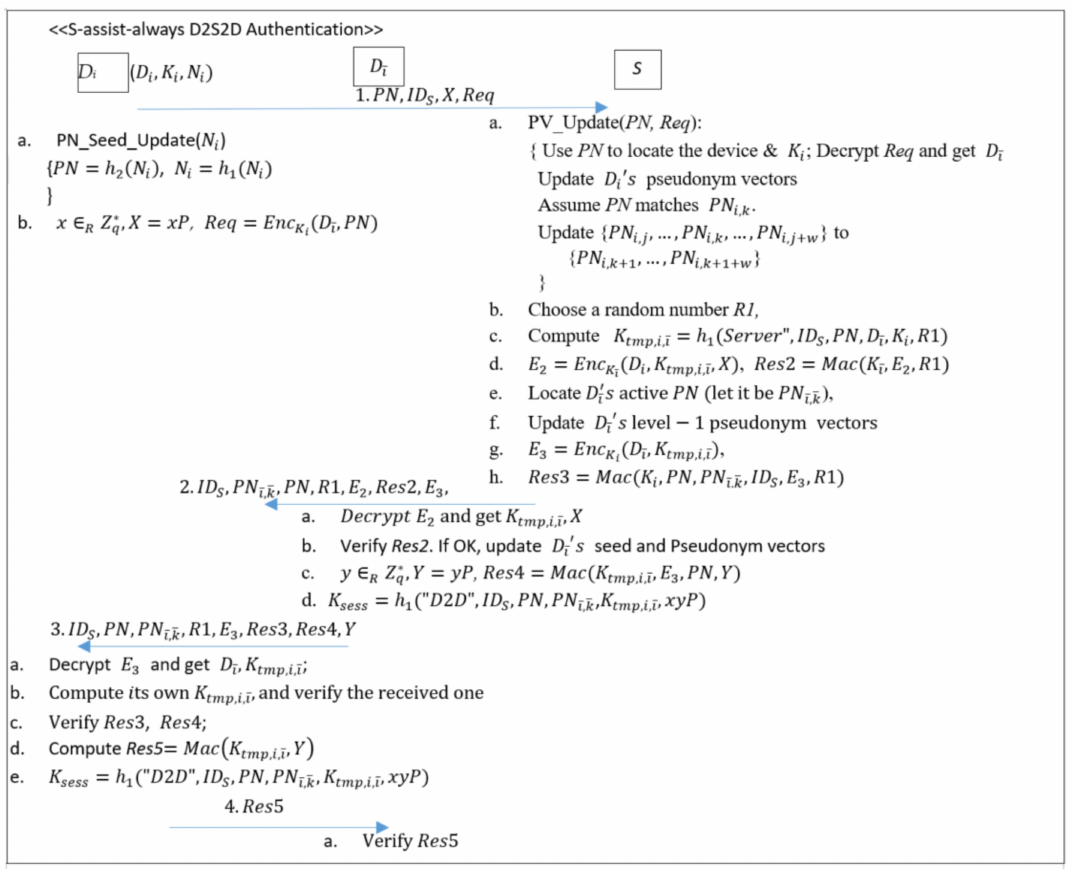
Figure 4. S-assist-always D2D anonymous authentication